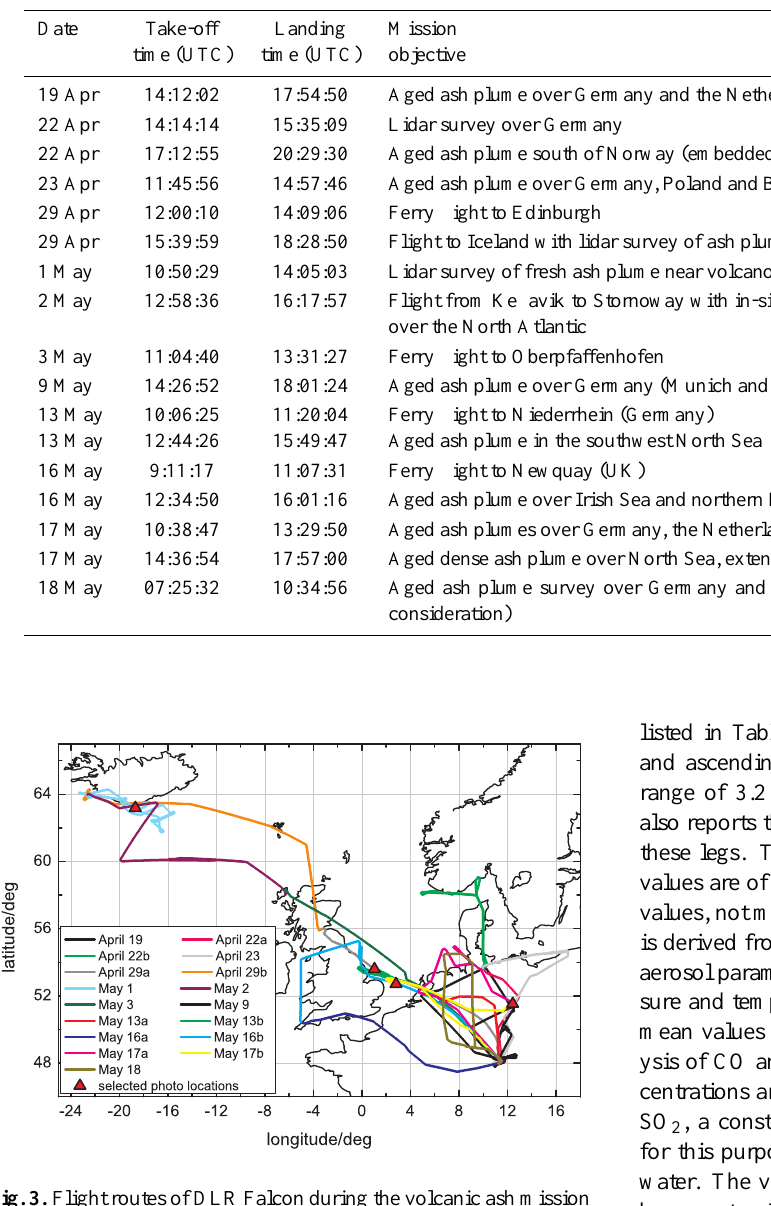
Fig. 3. Flight routes of DLR Falcon during the volcanic ash mission in April/May 2010. The photos shown in Fig. 10 were taken at the positions identified by